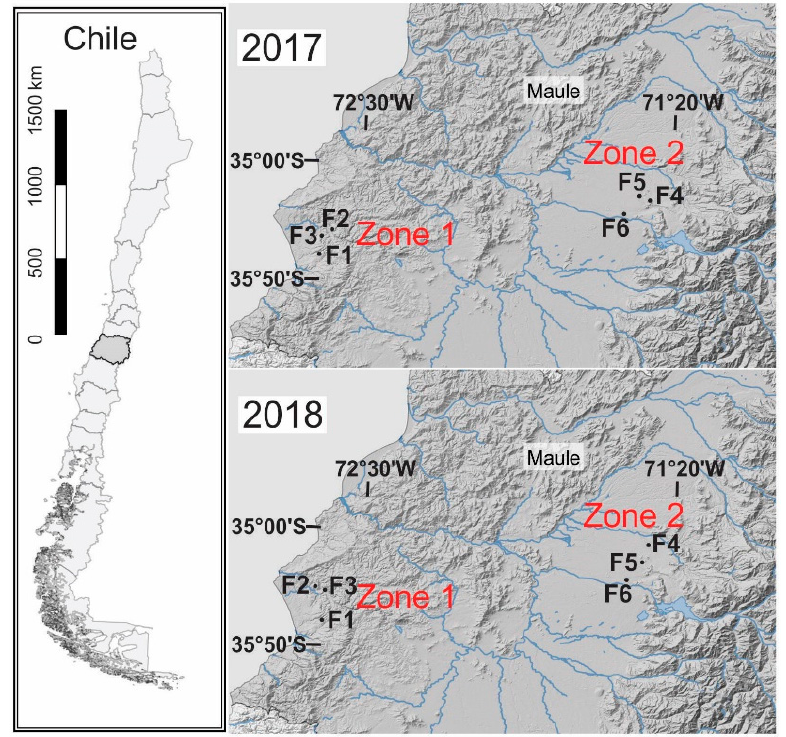
Figure 1. Location of the sampled zones for 2017 and 2018. F1–F3 are the fields collected in Zone 1, and F4–F6 are fields collected in Zone 2 (Table S1).